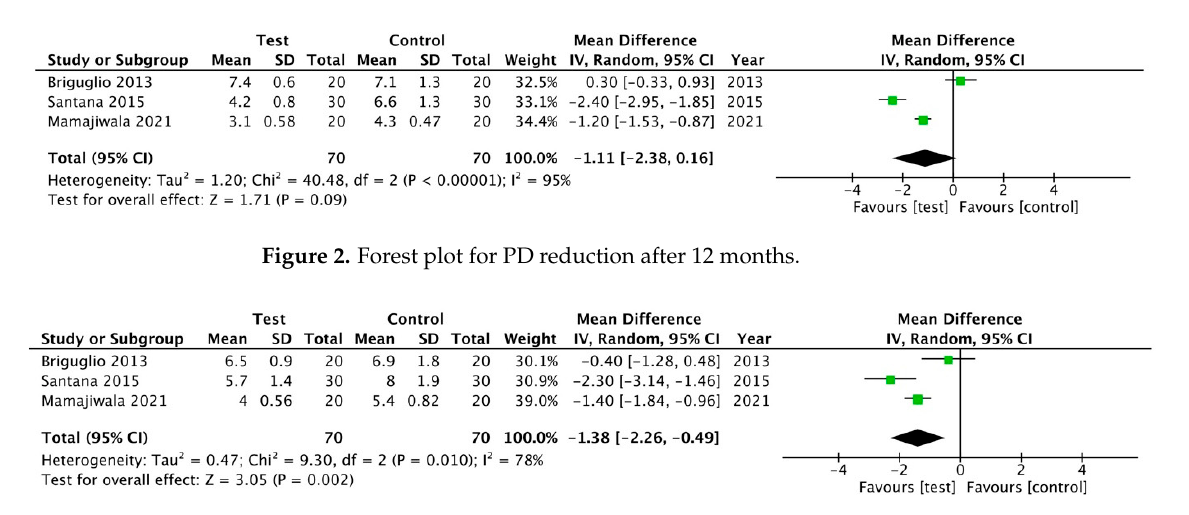
Figure 3. Forest plot for CAL gain after 12 months.